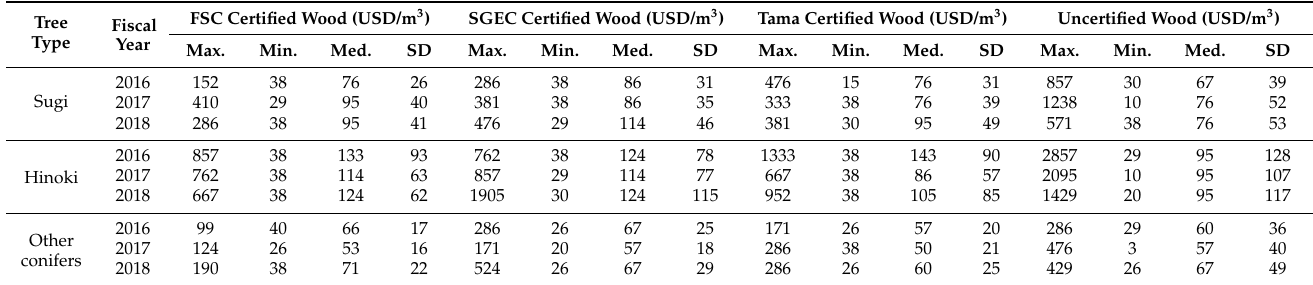
Table 1. Maximum, minimum, median, and standard deviation price of certified and uncertified wood by tree type at Tama Roundwood Market